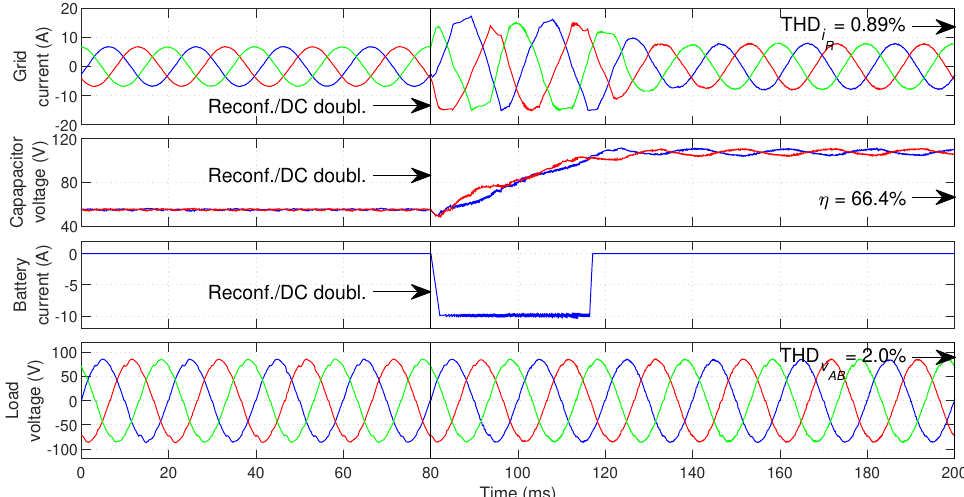
Figure 18. Normal and fault-tolerant UPS operation when an OC occurs in anti-parallel diode D R 1 of the